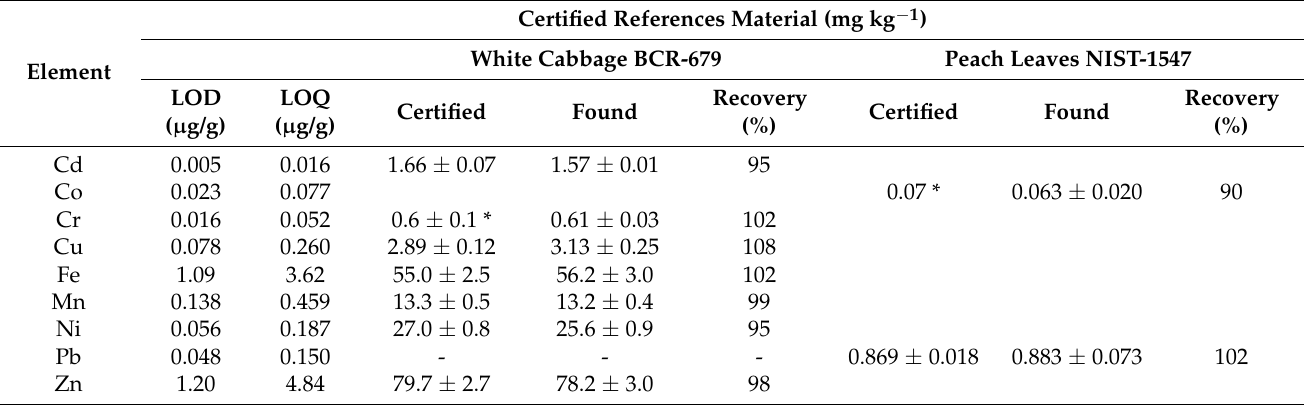
Table 2. Analysis of certified references materials (mean ± standard deviation), limit of detection and limit of quantification.